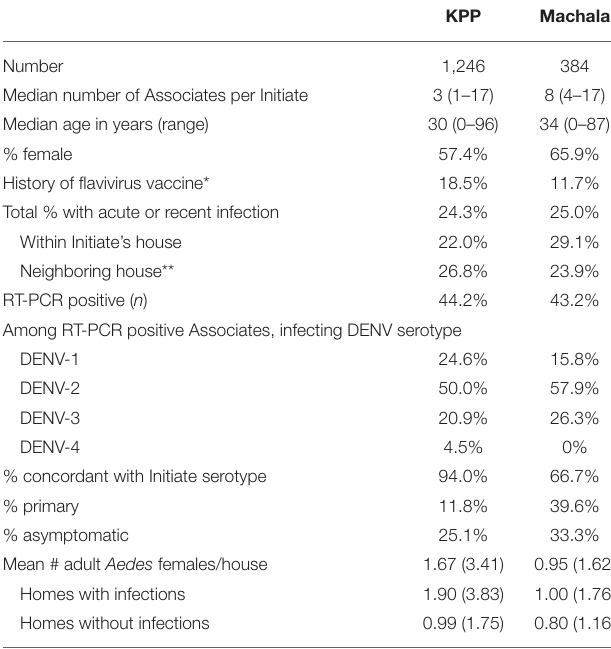
TABLE 4 | Features of enrolled Associates in Thailand and